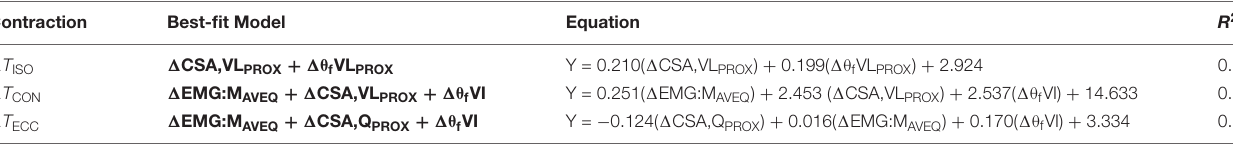
TABLE 3 | The best-fit model for predicting changes in maximum isometric and isokinetic concentric and eccentric torque ( (cid:49) T) from the changes in predictor variables ( (cid:49) VAR). Contraction Best-fit